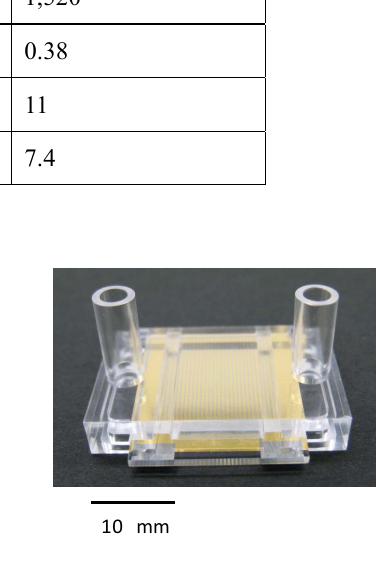
Fig. 6 Photograph of the micropump